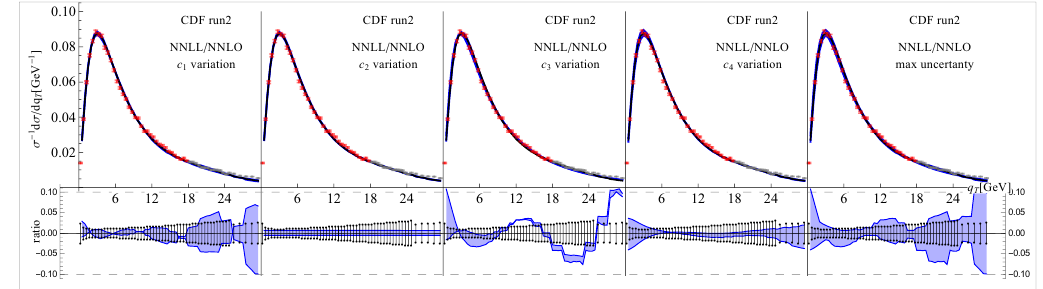
Figure 6 . E(cid:11)ect of variation of constants c i on the Z-boson production cross-section. The right panel shows the envelope of bands. The picture is from [1]. For the de(cid:12)nition of perturbative orders and other details see